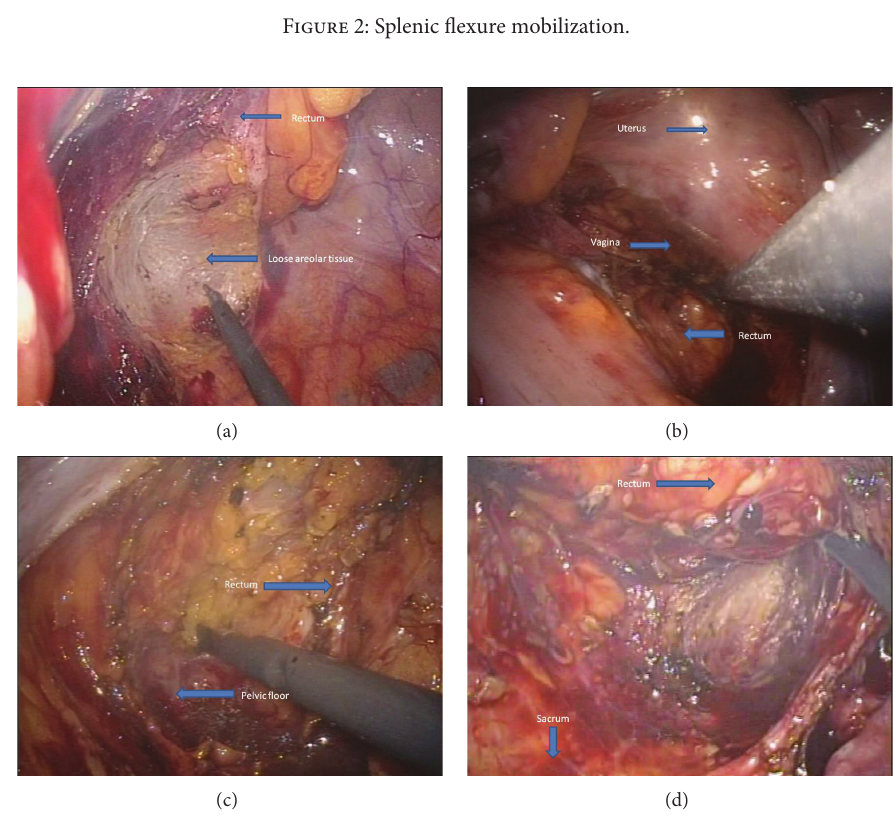
Figure 3: Pelvic